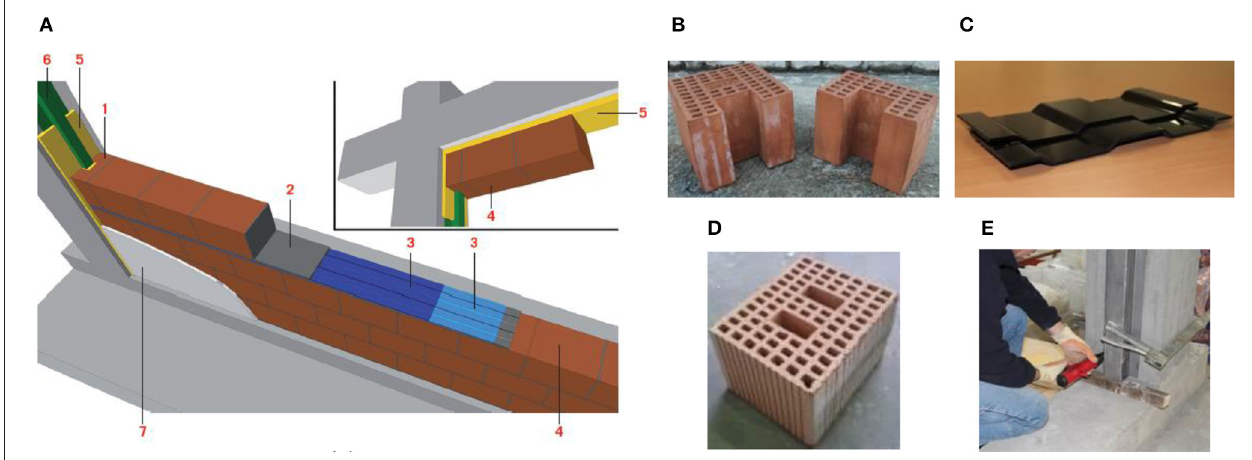
FIGURE 5 | (A) Details of the innovative masonry infill with sliding joints. (1) C-shaped units (B) . (2) Mortar bed joints. (3) Sliding joints (C) . (4) Clay units (D) . (5) Interface joints. (6) Shear keys (E) . (7) Plaster (Morandi et al., 2018).